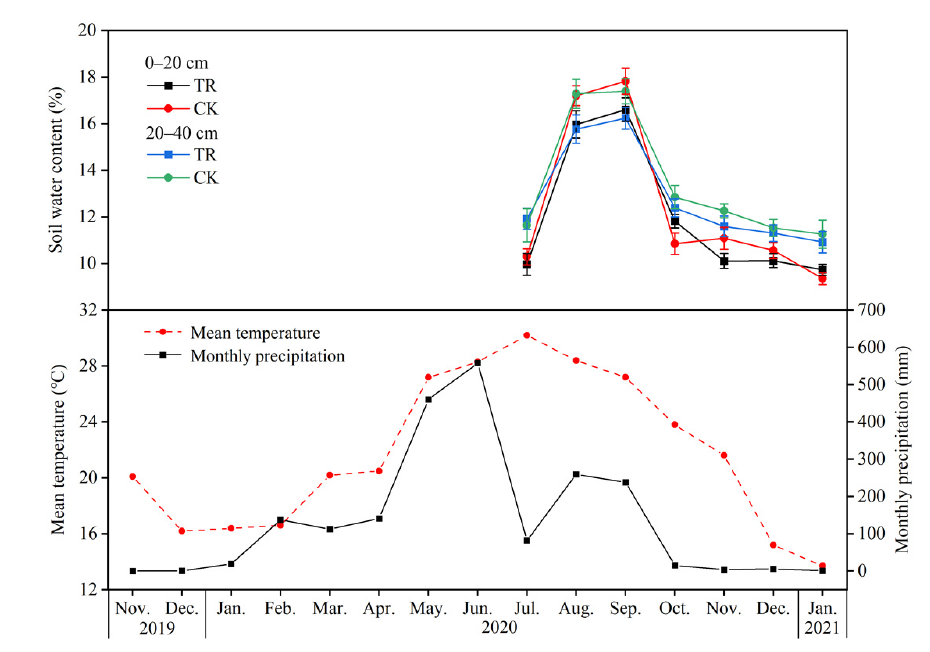
Figure 1. Soil water content, monthly precipitation and mean temperature from November 2020 to January 2021 after setting penetrating rain interception device. CK, control; TR, throughfall reduction, the same below.